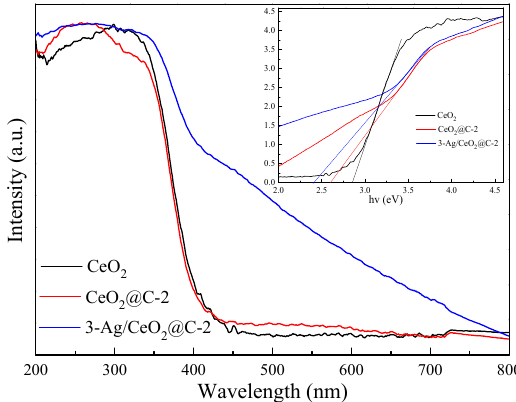
Figure 4. UV–Vis spectra of CeO 2 , CeO 2 @C-2, and 3-Ag / CeO 2 @C-2.